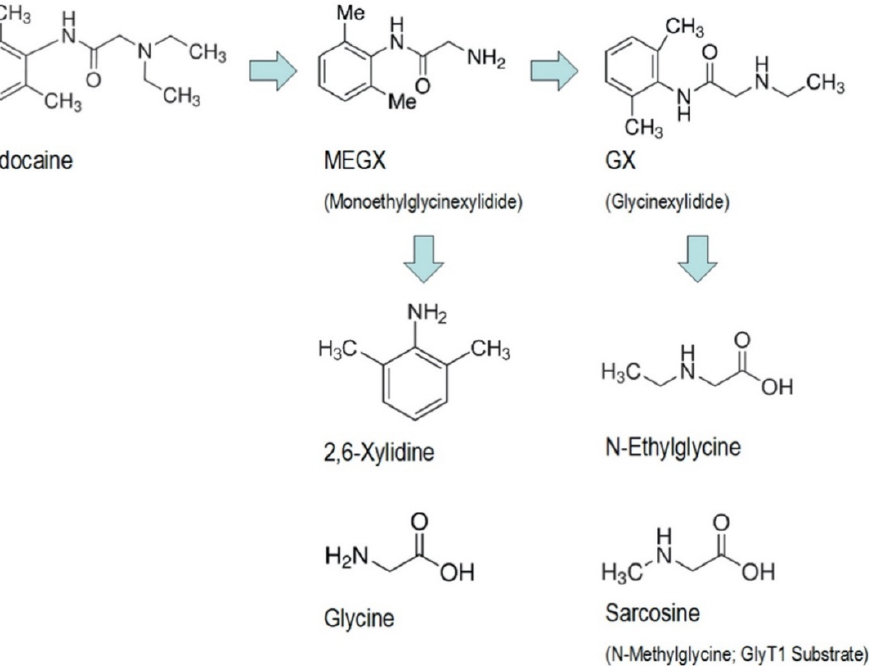
Figure 1. Chemical structure of lidocaine and its metabolites. Reprinted from Ref. [9], Copyright 2019, with permission from Elsevier.